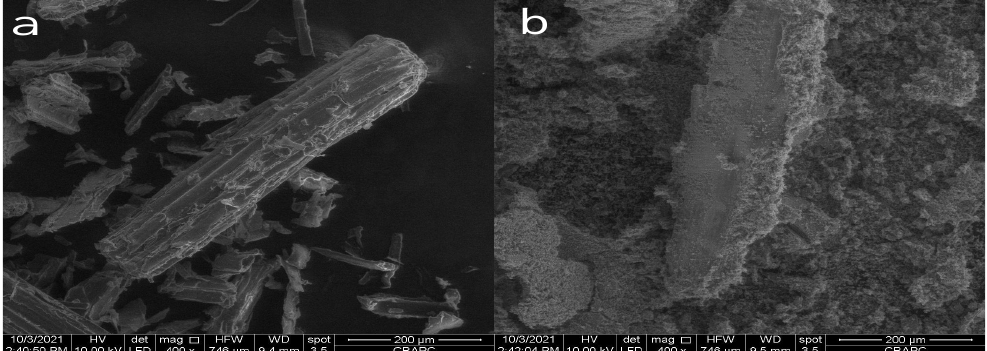
Figure 9. ( a ) net fiber form; ( b ) plaster sticking to wheat straw fibers.